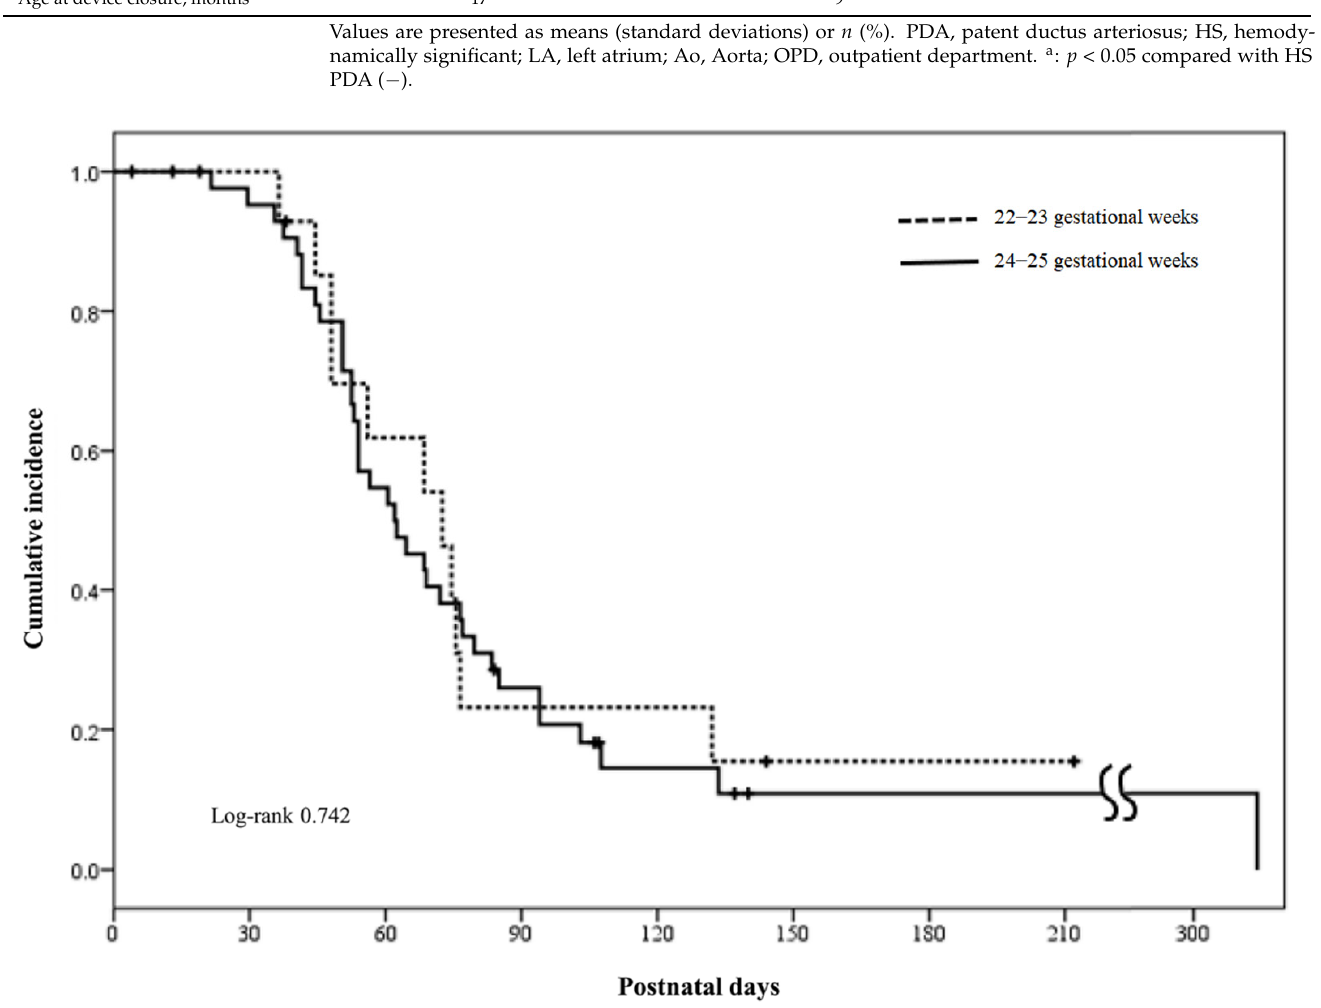
Figure 1. Cumulative incidence of ductal patency during hospitalization in the infants with initial HS PDA according to gestational